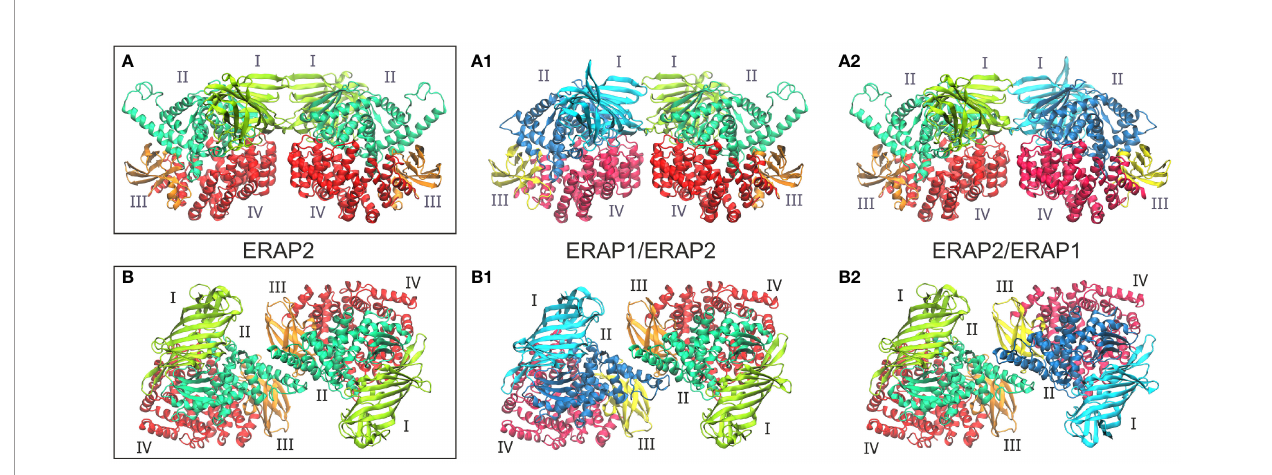
FIGURE 1 | (A, B) Crystallographic structures of ERAP2 homodimers in the two different topologies formed within the unit cell, and which were used as templates for the 4 heterodimeric ERAP1/ERAP2 models. For each dimer, both possible topologies of ERAP1/ERAP2 (A1, B1) and ERAP2/ERAP1 (A2, B2) heterodimers were investigated. Domains are color-coded as indicated for each enzyme with Latin